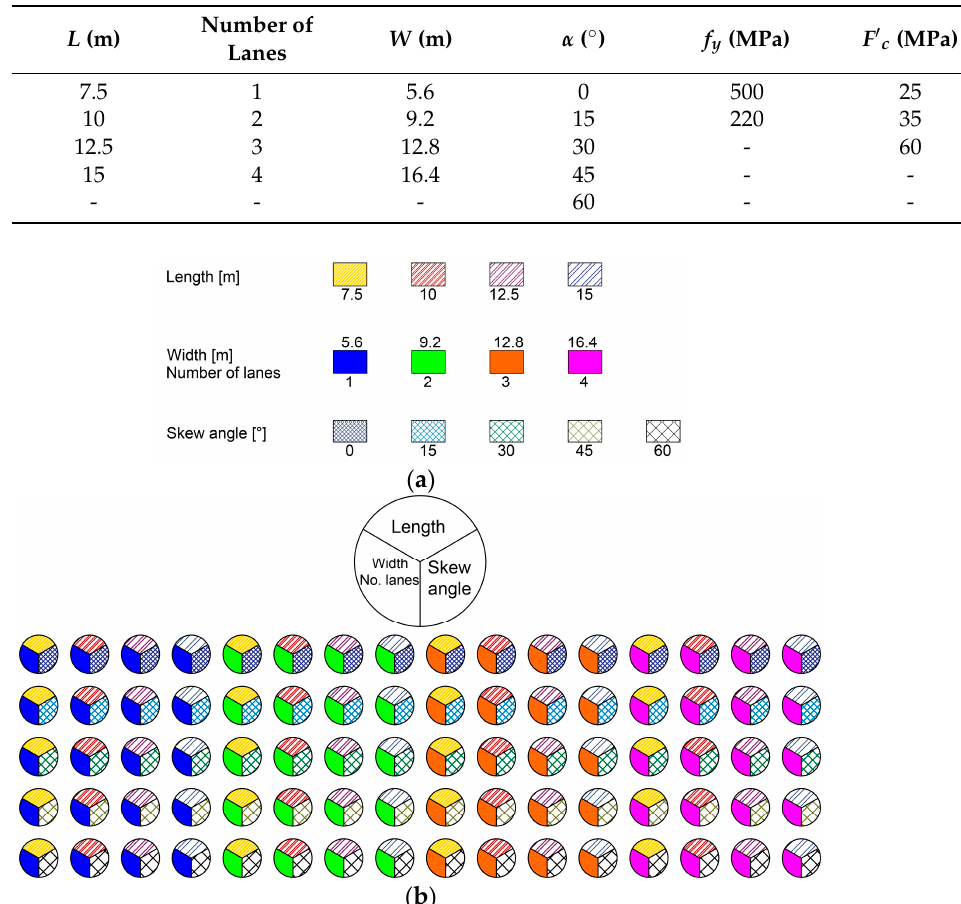
Figure 3. Illustration of the 80 case study bridges. ( a ) Parameters considered, and ( b ) geometric properties of the case study